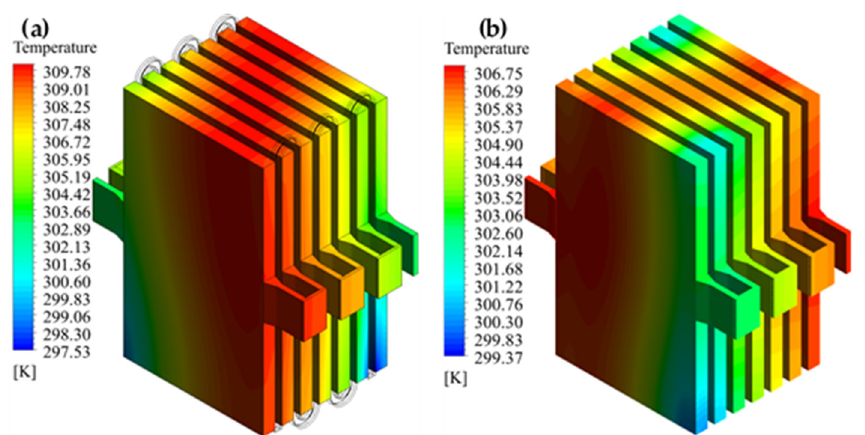
Figure 6. Temperature distribution of the battery pack using the ( a ) square and ( b ) round cooling pipes with H = 5 mm between the cooling pipe and terminal.